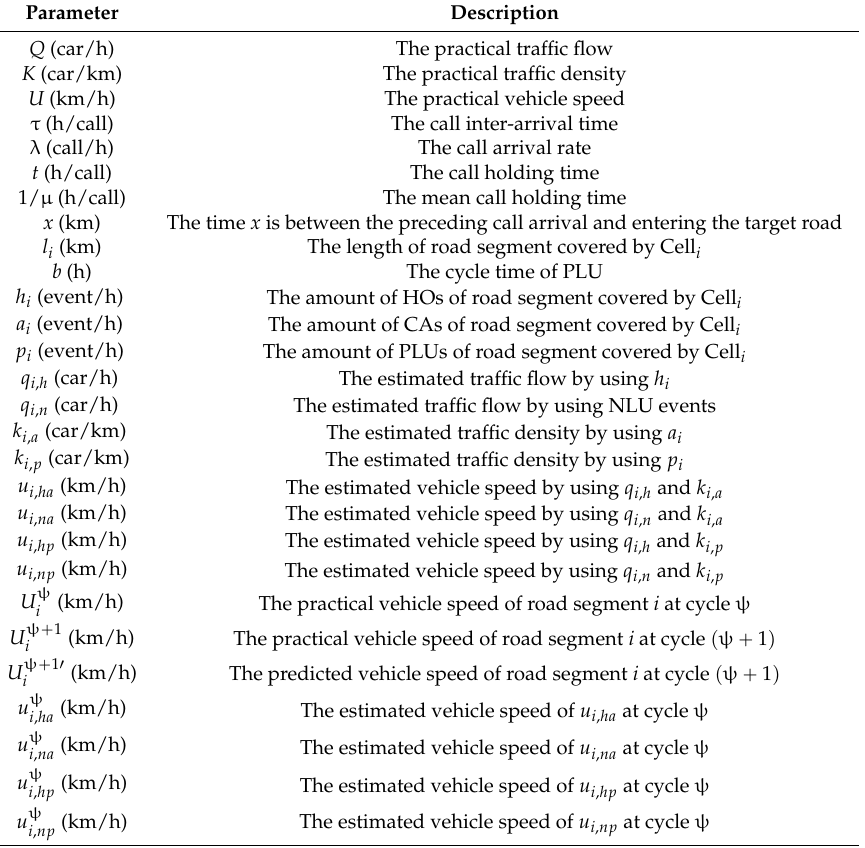
Table 1. The definition of notation. PLU, periodic location update; HO, handover; CA, all arrival; NLU, normal location